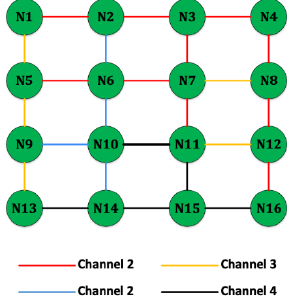
Fig. 1. 4x4 Grid Wireless Mesh Network with 4 channel